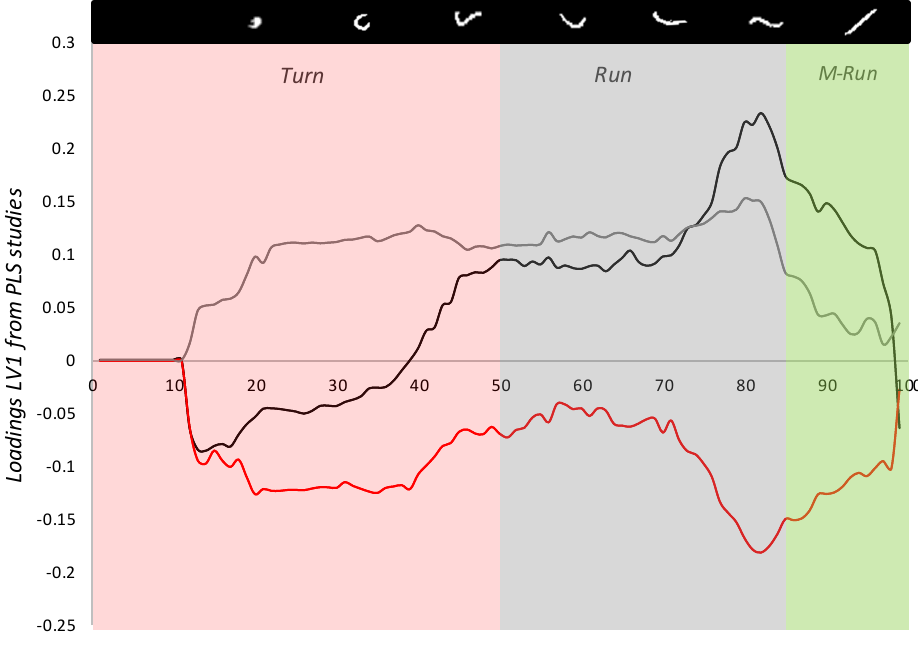
Table 1. Regression studies of Block A and mortality with Block B.